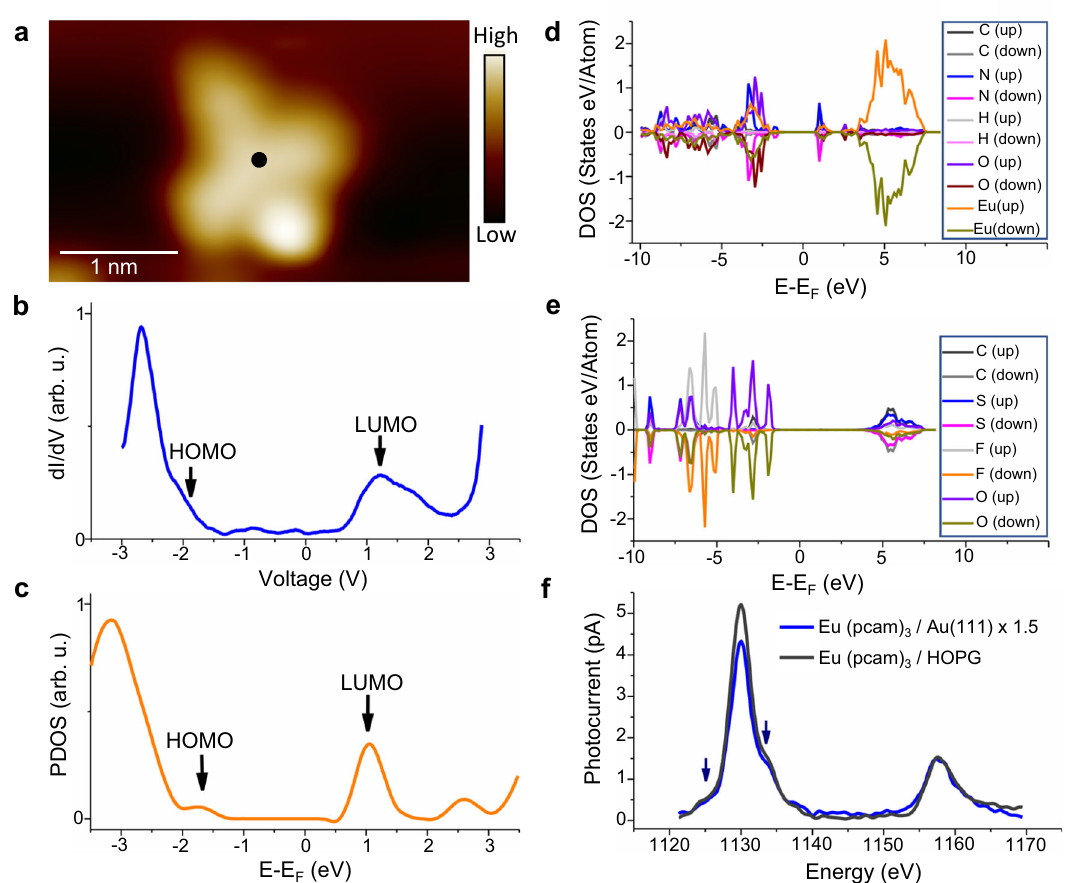
Fig. 3 | Electronic structure and chemical state. a STM image of complex [Eu(pcam) 3 × 2 ] + on Au(111) [V t = − 1.1V, I t =4.3×10 − 11 A, 5K]. b A dI/dV spectrum measured at the centre of [Eu(pcam) 3 X 2 ] + such as shown with a black dot in ( a ) shows the HOMO, and LUMO. c Projecteddensity of states (PDOS)ofthe complex asafunctionofenergyshowsHOMOandLUMOpeaksofEu(pcam) 3 unitadsorbed